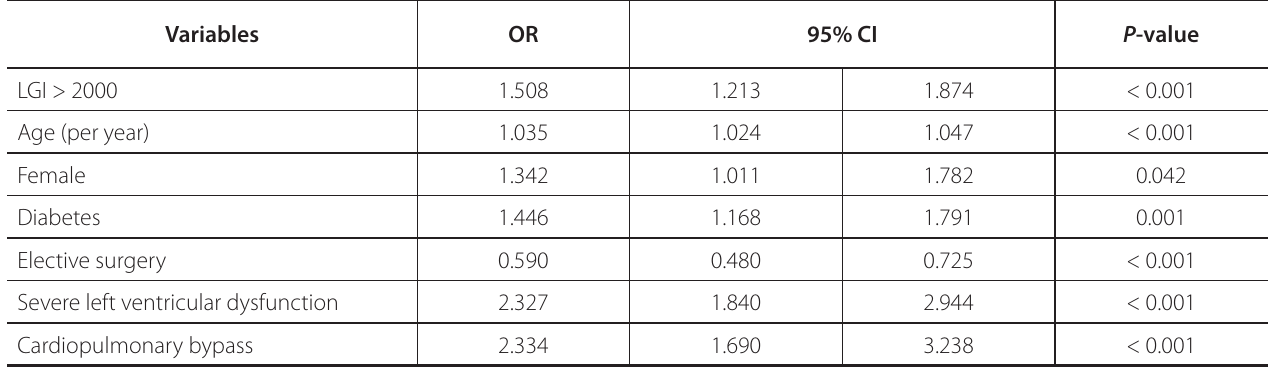
Table 4 . Multivariate logistic regression model for in-hospital mortality, LCO, or AKI.